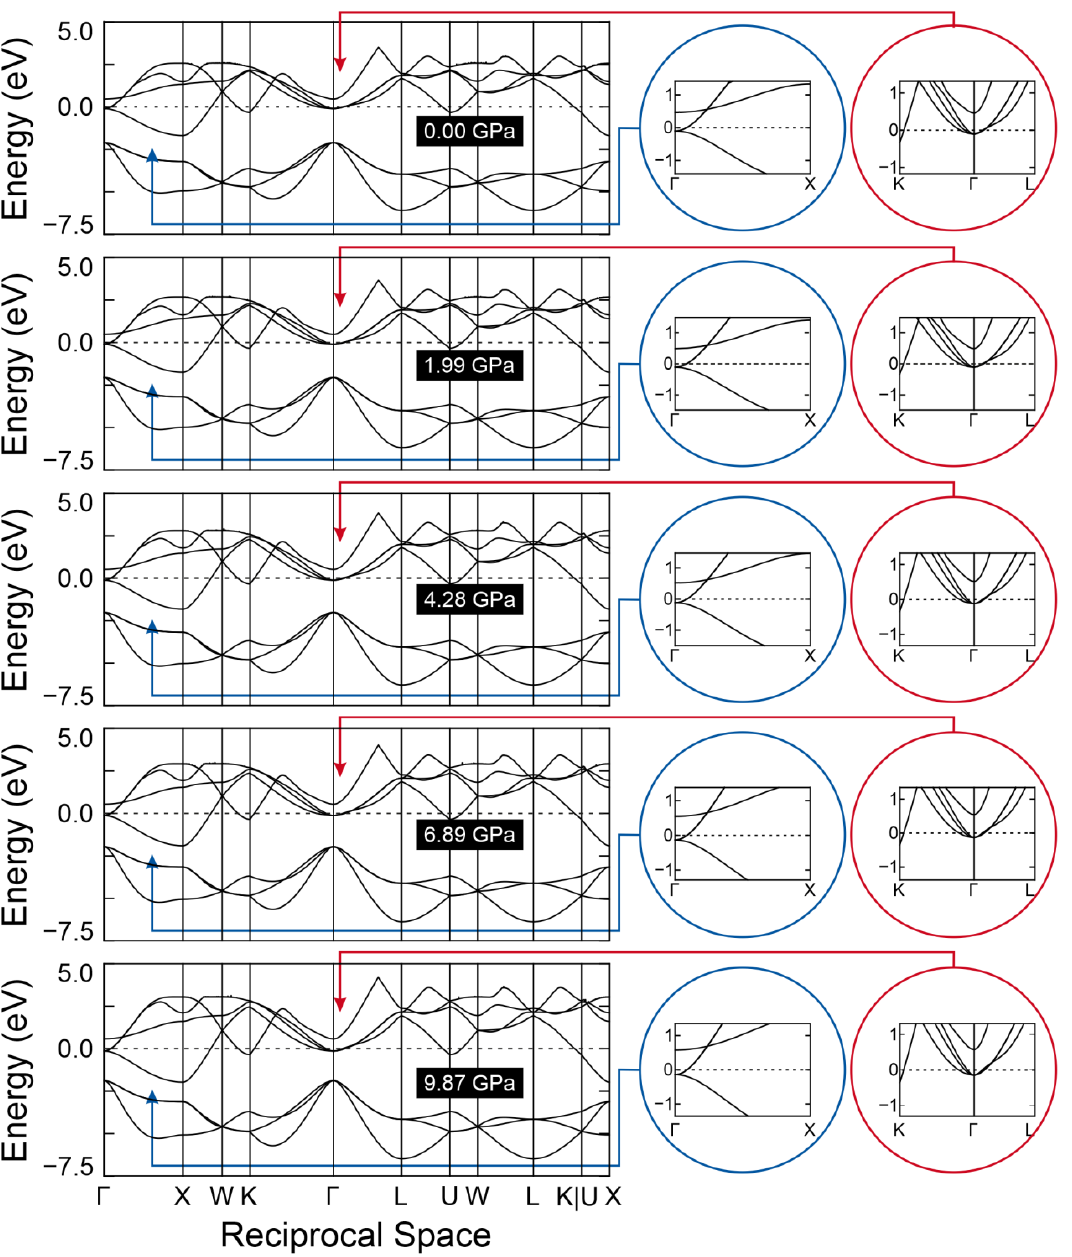
Figure 2. Pressure-dependent electronic band structures of the rock-salt-type YTe: energy regions that comprise flat bands positioned close to the Fermi levels, E F , are shown in the insets, while the dotted horizontal lines represent the Fermi levels.